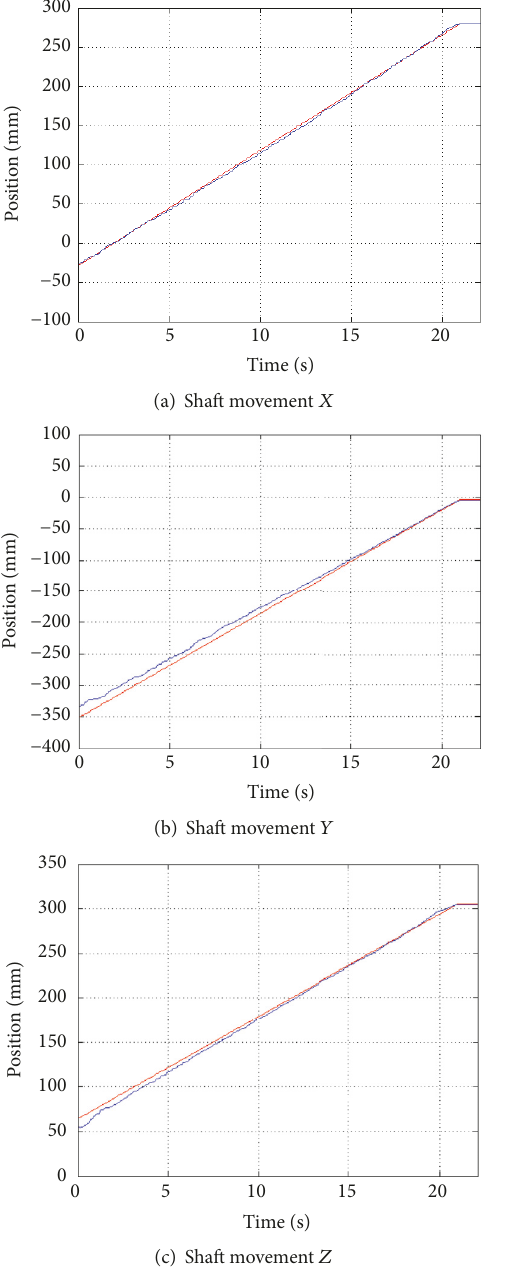
Figure 18: Cartesian movement of the MOVEC